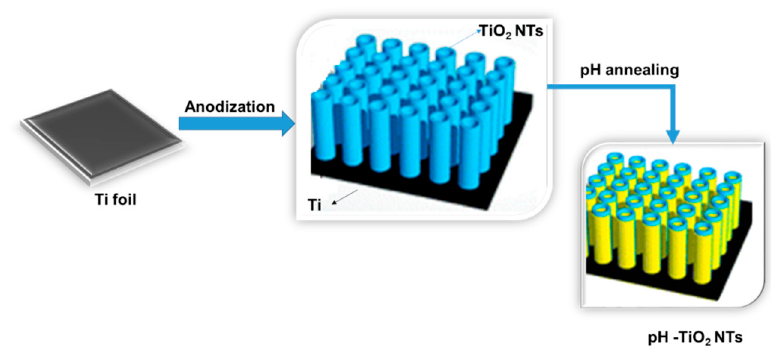
Figure 5. Schematic modification of TiO 2 nanotubes; adapted from [83,92].